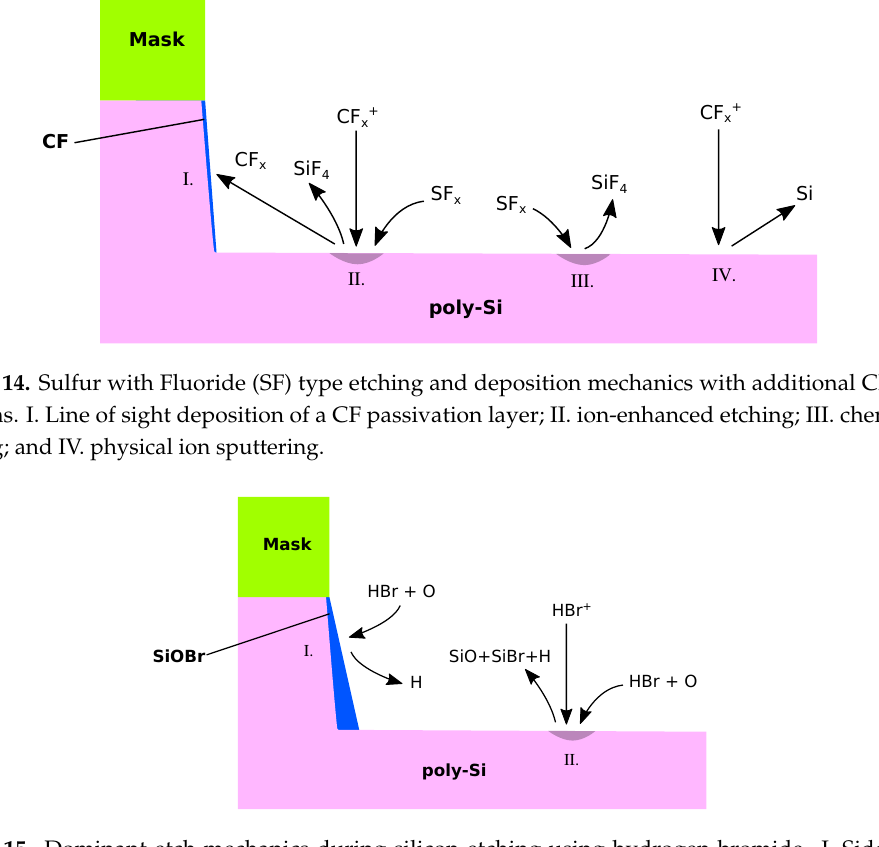
Figure 15. Dominant etch mechanics during silicon etching using hydrogen bromide. I. Sidewall passivation proceeds though chemical deposition from the gas phase, while II. vertical etching is dominated by ion-enhanced